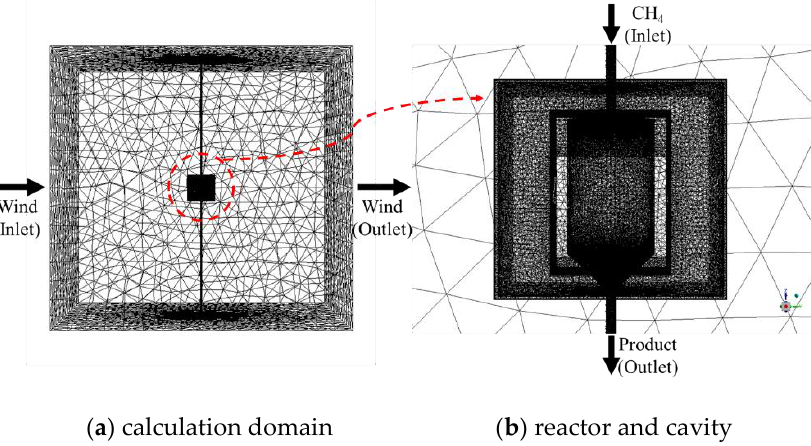
Figure 15. Transformation of 2D optical results to 3D CFD boundary condition.